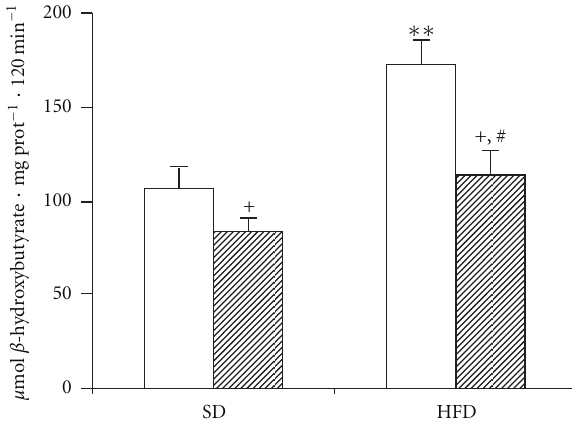
Figure 5: The e ff ect of HFD on β -hydroxybutyrate production from liver slices in vitro. Liver slices were incubated in oxygenated KRB without exogenous fatty acids. Open bars = fasted animals; hatched bars = fed animals. + P < 0 . 05 fed versus fasted; ∗∗ P < 0 . 01 HFD versus SD fasted; # P < 0 . 05; # P < 0 . 05 HFD fed versus SD